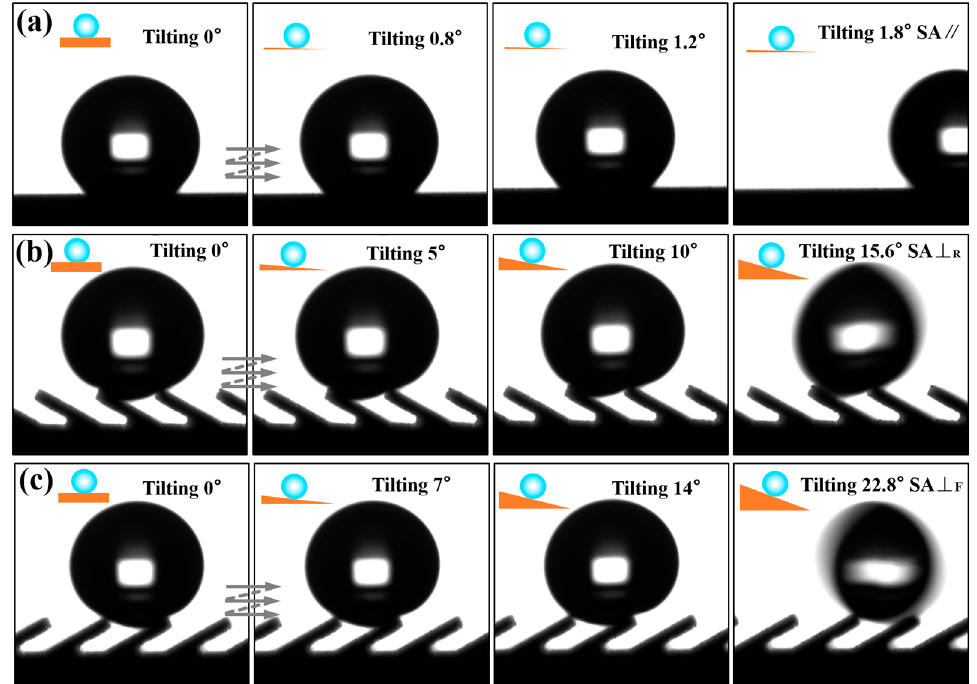
Figure 8. The sliding angles of water droplet in different directions on the inclined groove surface ( L = 300 µm, A = 30°): ( a ) sliding along the direction parallel to the inclined groove; ( b ) reversely sliding in the direction perpendicular to the inclined groove; ( c ) forward sliding in the direction perpendicular to the inclined groove.